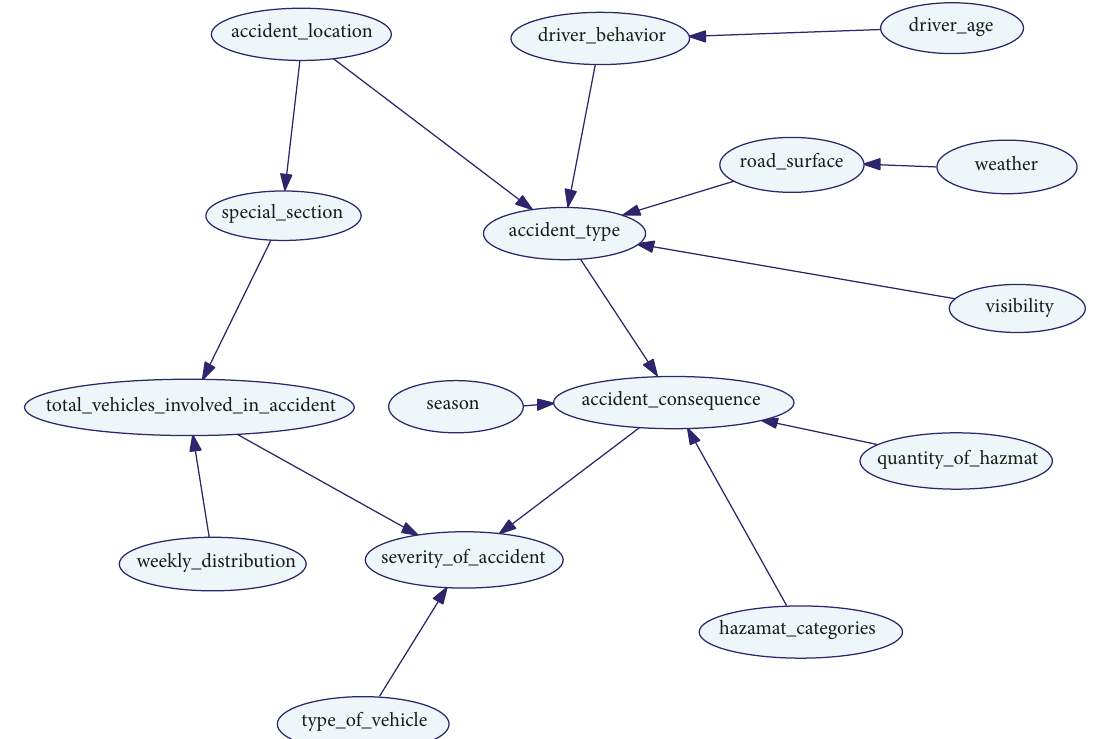
Figure 2: The Bayesian network structure for Hazmat road transportation